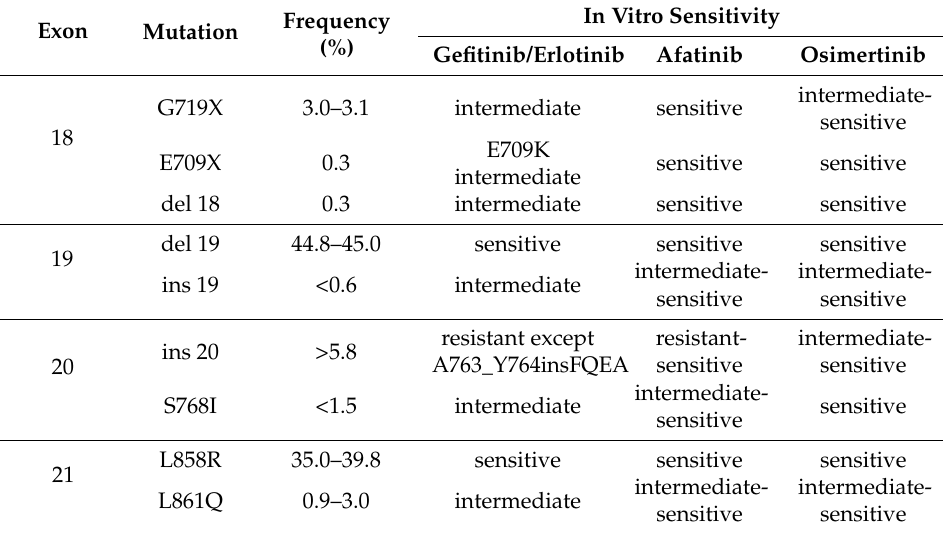
Table 1. Frequency of uncommon EGFR mutations and drug sensitivity